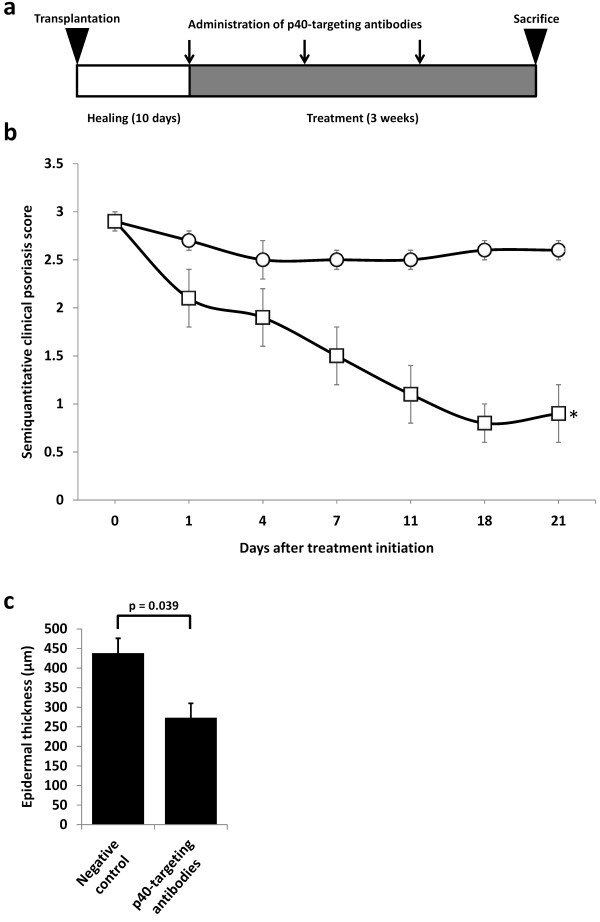
Amelioration of psoriasis by treatment of mice xenotransplanted with psoriatic skin with systemically administered p40-targeting antibodies. (a) Schematic schedule of treatment with p40-targeting antibodies (Ustekinumab). Psoriatic skin grafts were xenotransplanted onto the back of SCID mice and allowed to heal for ten days. The mice were then treated by weekly intraperitoneal injection of p40-targeting antibodies or negative control. The mice were sacrificed after three weeks of treatment. (b) Semiquantitative clinical psoriasis scores were given twice weekly for the three-week treatment duration to mice treated with the negative control (open circles, n = 11) or p40-targeting antibodies (open squares, n = 4). Injections were performed at day 0, 7, and 14. All data points are presented as mean ± SEM. *p = 0.003. (c) At treatment endpoint, mice were sacrificed and biopsies from the skin grafts were fixed, paraffin-embedded, H&E-stained, and epidermal thickness was measured in each graft. All data points are presented as mean + SEM.